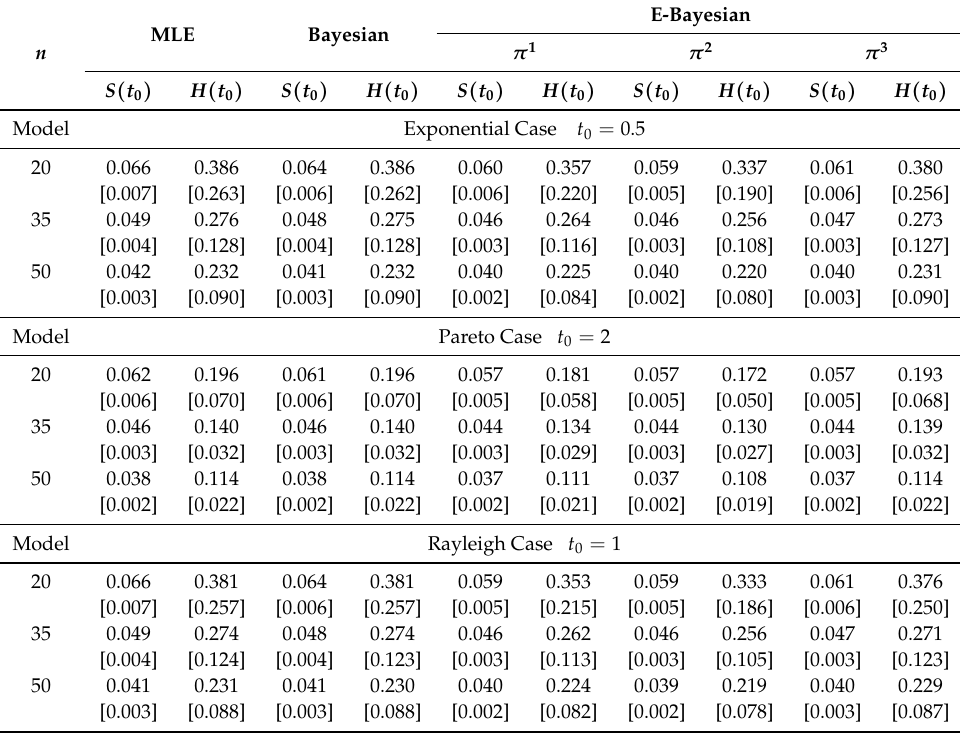
Table 3. The AB and MSEs (within bracket) of point estimates with ( c 1 , c 2 , c 3 ) = ( 1.5,2,1.2 ) .